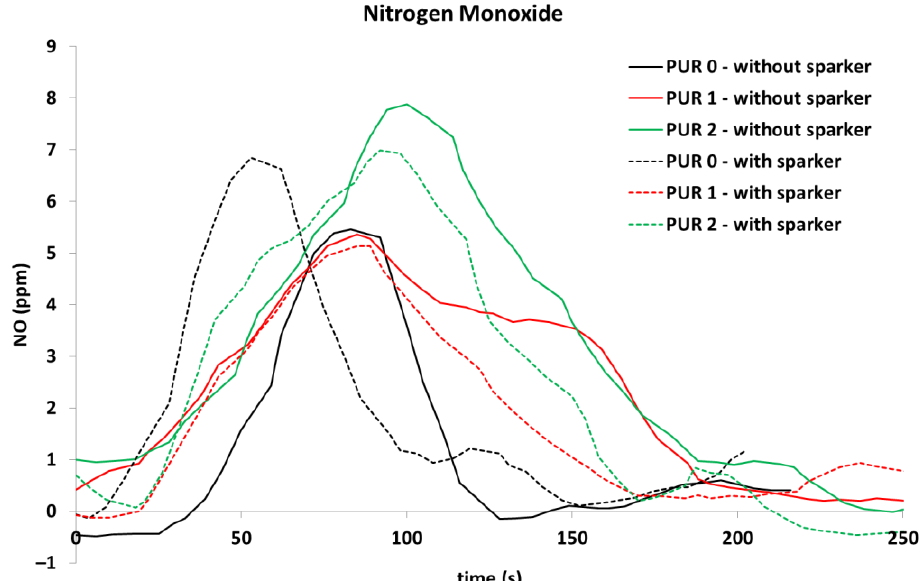
Figure 12. Nitrogen monoxide release, during exposure of the PURs to the 40 kW/m 2 of heat flux; self-ignited and ignited with a spark igniter.